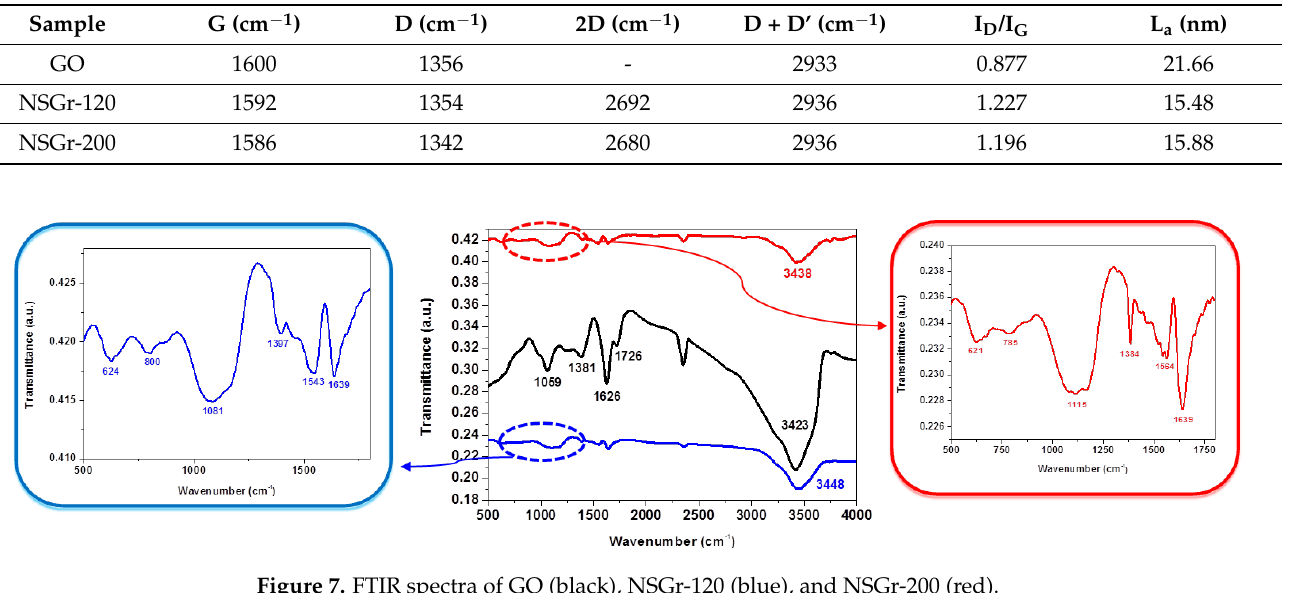
Figure 7. FTIR spectra of GO (black), NSGr-120 (blue), and NSGr-200 (red).